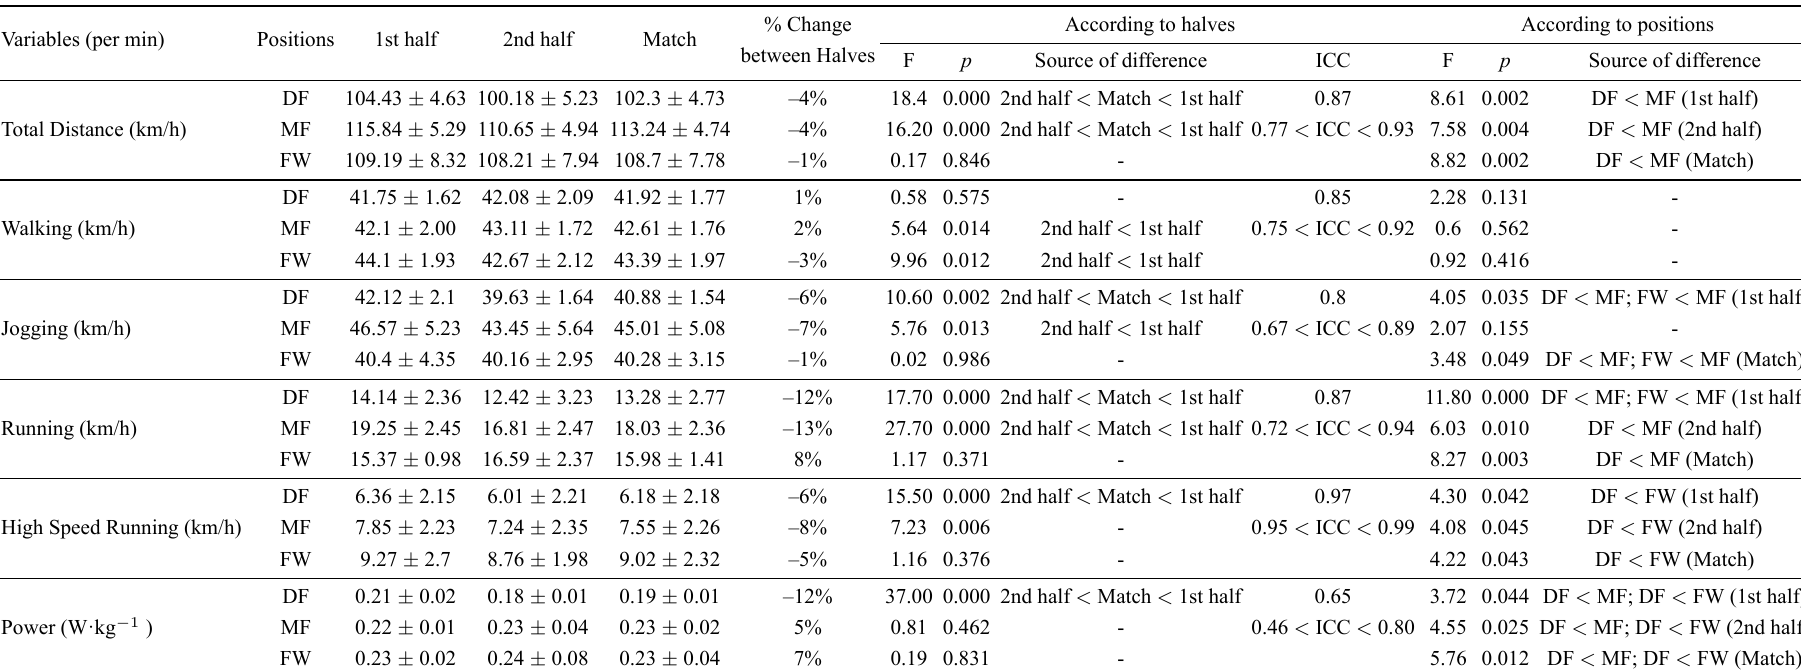
Table 1. Between-position and within-position differences according to match